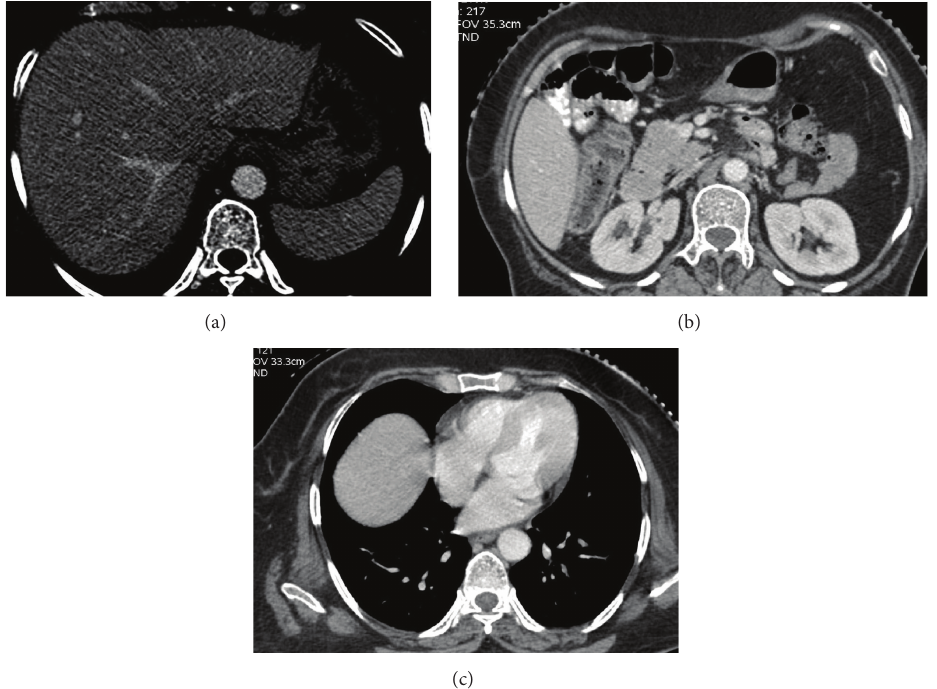
Figure 4: CT scan after six cycles of chemotherapy reveals complete resolution of the liver, pancreatic, and chest wall